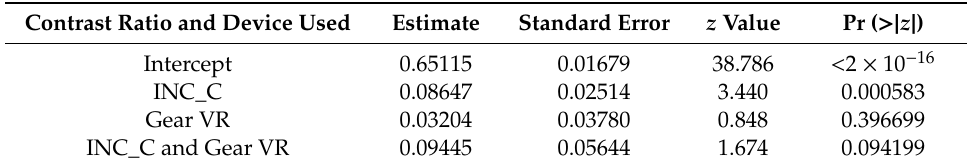
Table 26. Logistic regression analysis results of the additive model with variables contrast ratio and device used allowing interactions.